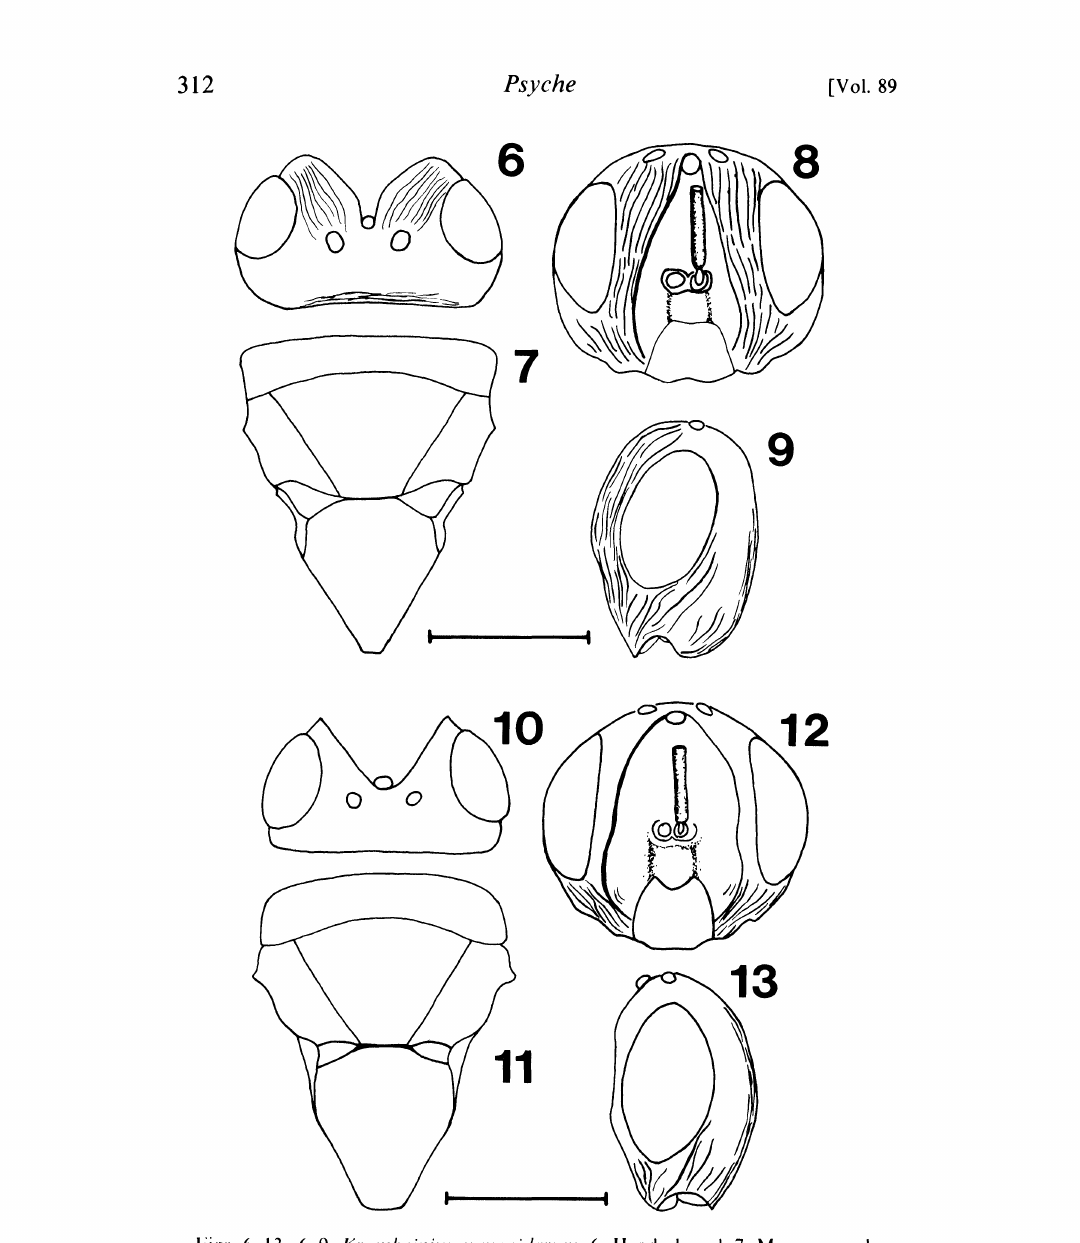
Figs. 6 13. 6-9. Kronlheinius euntenidarunt. 6. Head, dorsal. 7. Mesosoma, dor- sal. 8. Head, frontal. 9. Head, lateral. 10-13. K. megalaspis. 10. Head, dorsal. II. Mesosoma, dorsal. 12. Head, frontal. 13. Head, lateral. [Scale line